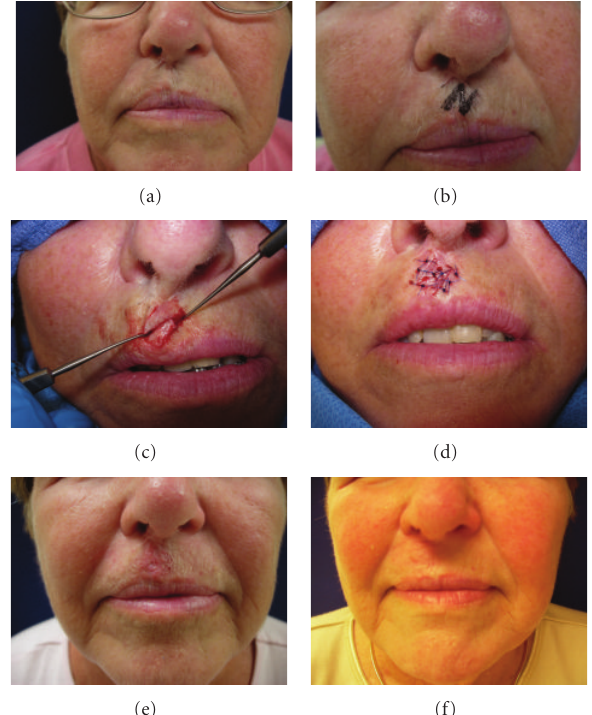
Figure 1: (a) Complication of eclabium secondary to herpetic infection of an advancement flap of the upper lip. (b) A 45-degree Z-plasty is planned and drawn. (c) The flaps are widely undermined and transposed. Note the use of skin hooks to minimize trauma to the tenuous tips. (d) Flaps sutured in place. Transposition of the triangular flaps brings about the following changes: the central limb is rotated (from a vertical to a horizontal direction), the distance between the original vertical scar (or limb) is increased, and the final scar is “broken” from a straight line to a nonlinear Z configuration. (e) Patient at suture removal. Note the immediate correction of the eclabium. (f) Results at several months. The scar lines have become more subtle.